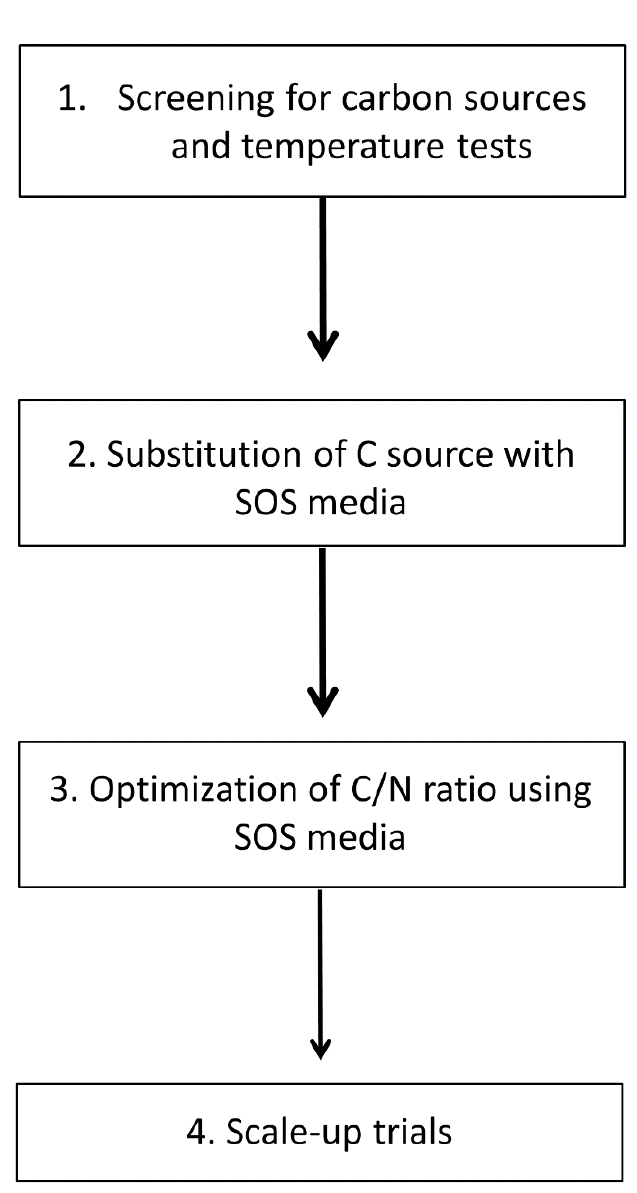
Figure 1. Scheme of experimental design proposed in this